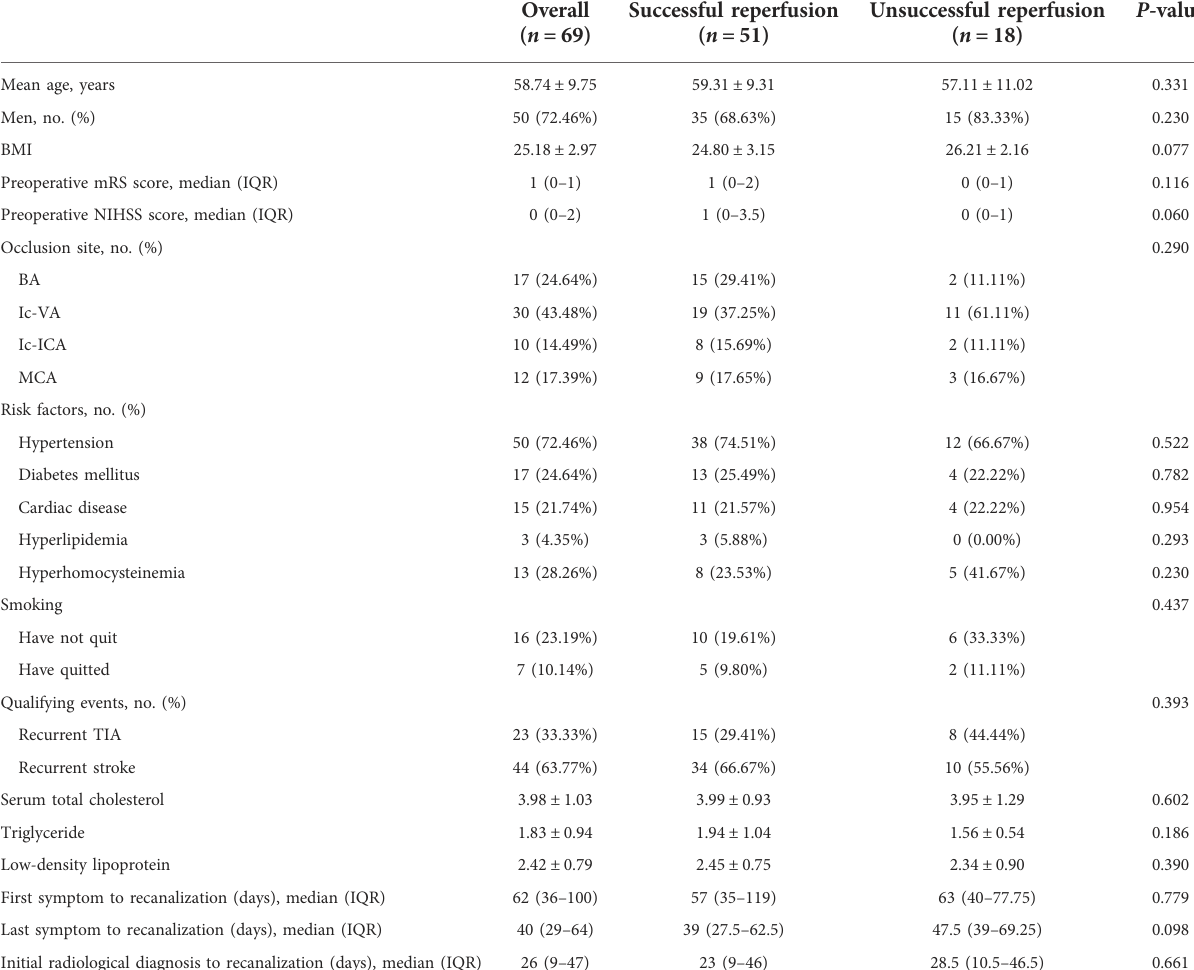
TABLE 1 Baseline